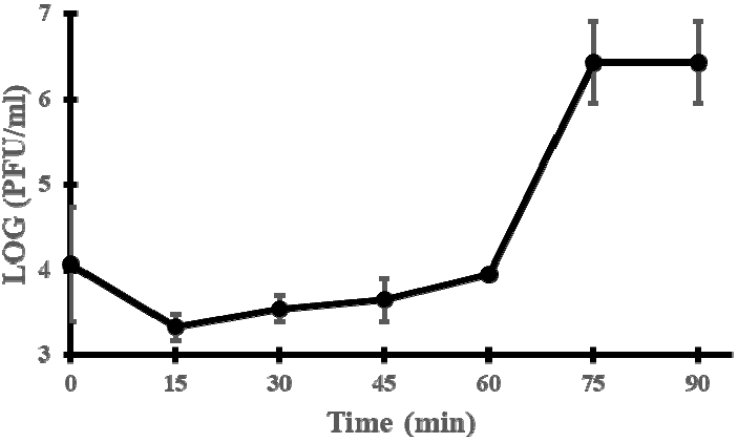
Figure 2. One-step growth curve of phage vB_EfmH_163. Log PFU/mL was measured every 15 min. Means and standard deviations of three independent replicates are shown.